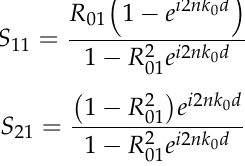
Figure 6. The absorption spectra of the design structure at 1.5 x 10 5 S/m VO 2 conductivities.